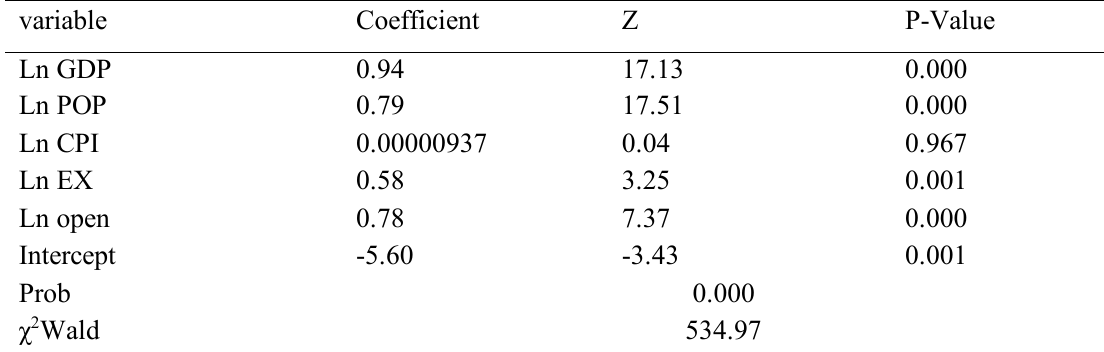
Table 5 . Regression